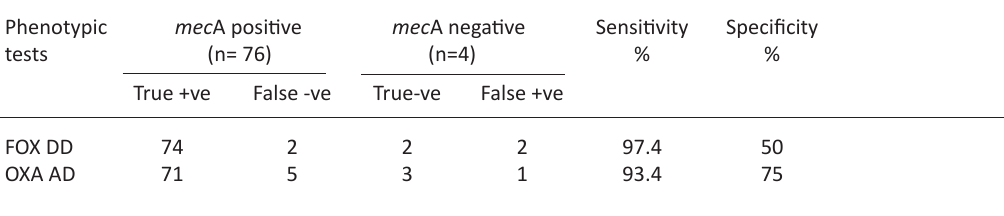
Table 1. Comparison of two phenotypic tests used for MRSA isolates detection versus the molecular detection method by PCR amplification of mecA gene.